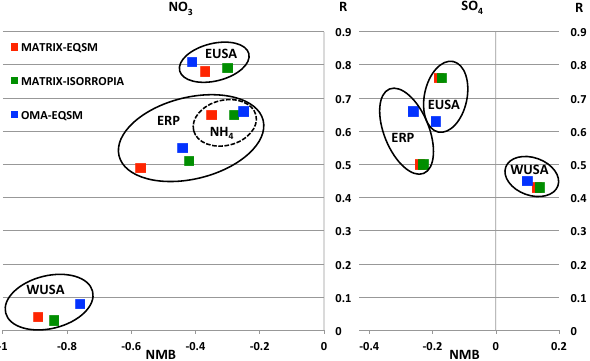
Figure 4. Surface regional statistics (2000–2010). Left panel: ni- trate and ammonium (data available only for ERP); right panel: sul- fate. The correlation coefficient ( R ) between the simulation and the measurements is in the y axis, and NMB is in the x axis. MATRIX- EQSAM is in red, MATRIX-ISORROPIA II is in green, and OMA- EQSAM is in blue.